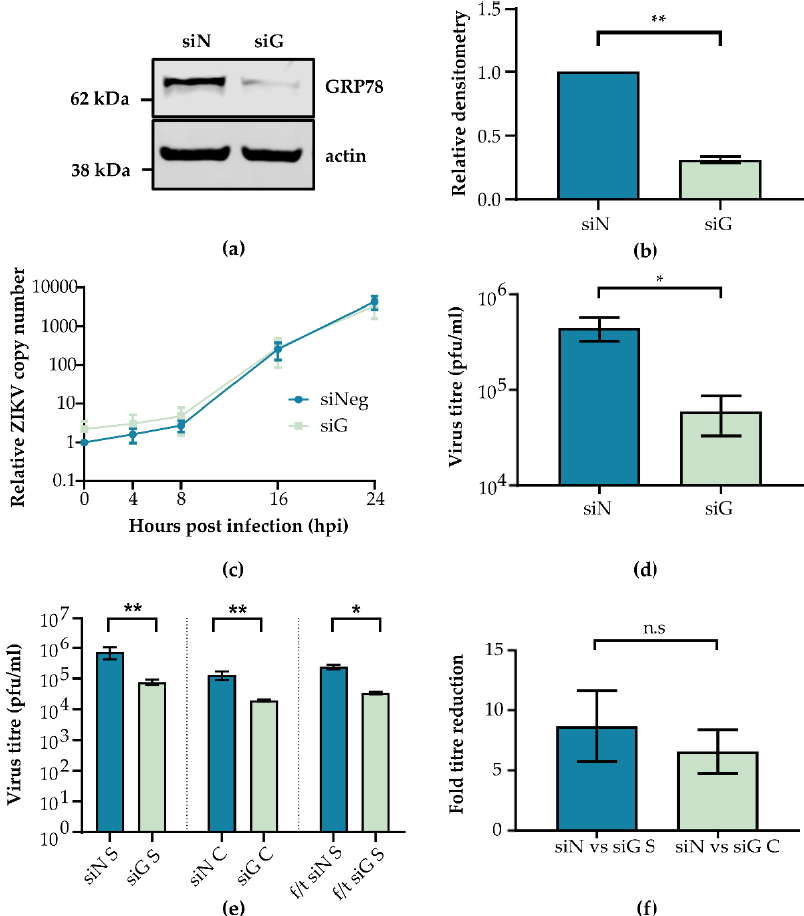
Figure 3. GRP78 depletion reduces ZIKV infectious particle release. A549 cells were treated with siRNA targeting GRP78 (siG) or negative control (siN) for 72 h. ( a ) A representative Western blot of triplicate repeats is shown. ( b ) Triplicate Western blots were analysed for GRP78 densitometry relative to actin levels to measure protein expression. ( c ) Cells treated with siRNA were infected with ZIKV PE243 at MOI 0.1. RNA was extracted at 4, 8, 16, and 24 h post infection. Viral RNA copy number was measured by RT-qPCR relative to a GAPDH control and normalised to viral RNA detected at 0 h in the siN sample. ( d ) Supernatant was harvested at 24 h post infection, and viral titre was measured via plaque assay. ( e ) Following siRNA treatment, cells were infected with ZIKV PE243 at MOI 5 for 24 h. Supernatant was harvested from siN and siG cells, and the titre was calculated for untreated supernatants (siN S and siG S) and freeze/thaw (f/t) supernatants (f/t siN S and f/t siG S). Monolayers corresponding to siN or siG supernatants were subject to 3× f/t cycles, and the titre was calculated (labelled siN C and siG C). ( f ) The reduction in titre between siN treated cells and siG shown in ( e ) is plotted, where siN vs. siG S represents samples taken from the supernatant, and siN vs. siG C is intracellular virus. The mean fold-reduction was calculated from three independent experiments, and error bars show the standard error of the mean. ( a – f ) Experiments were performed in triplicate, and the mean and the standard error of the mean are plotted. An unpaired Student’s t -test with Welch’s correction was used to determine statistical significance where n.s = not significant, * p -value < 0.05, ** p -value < 0.01.